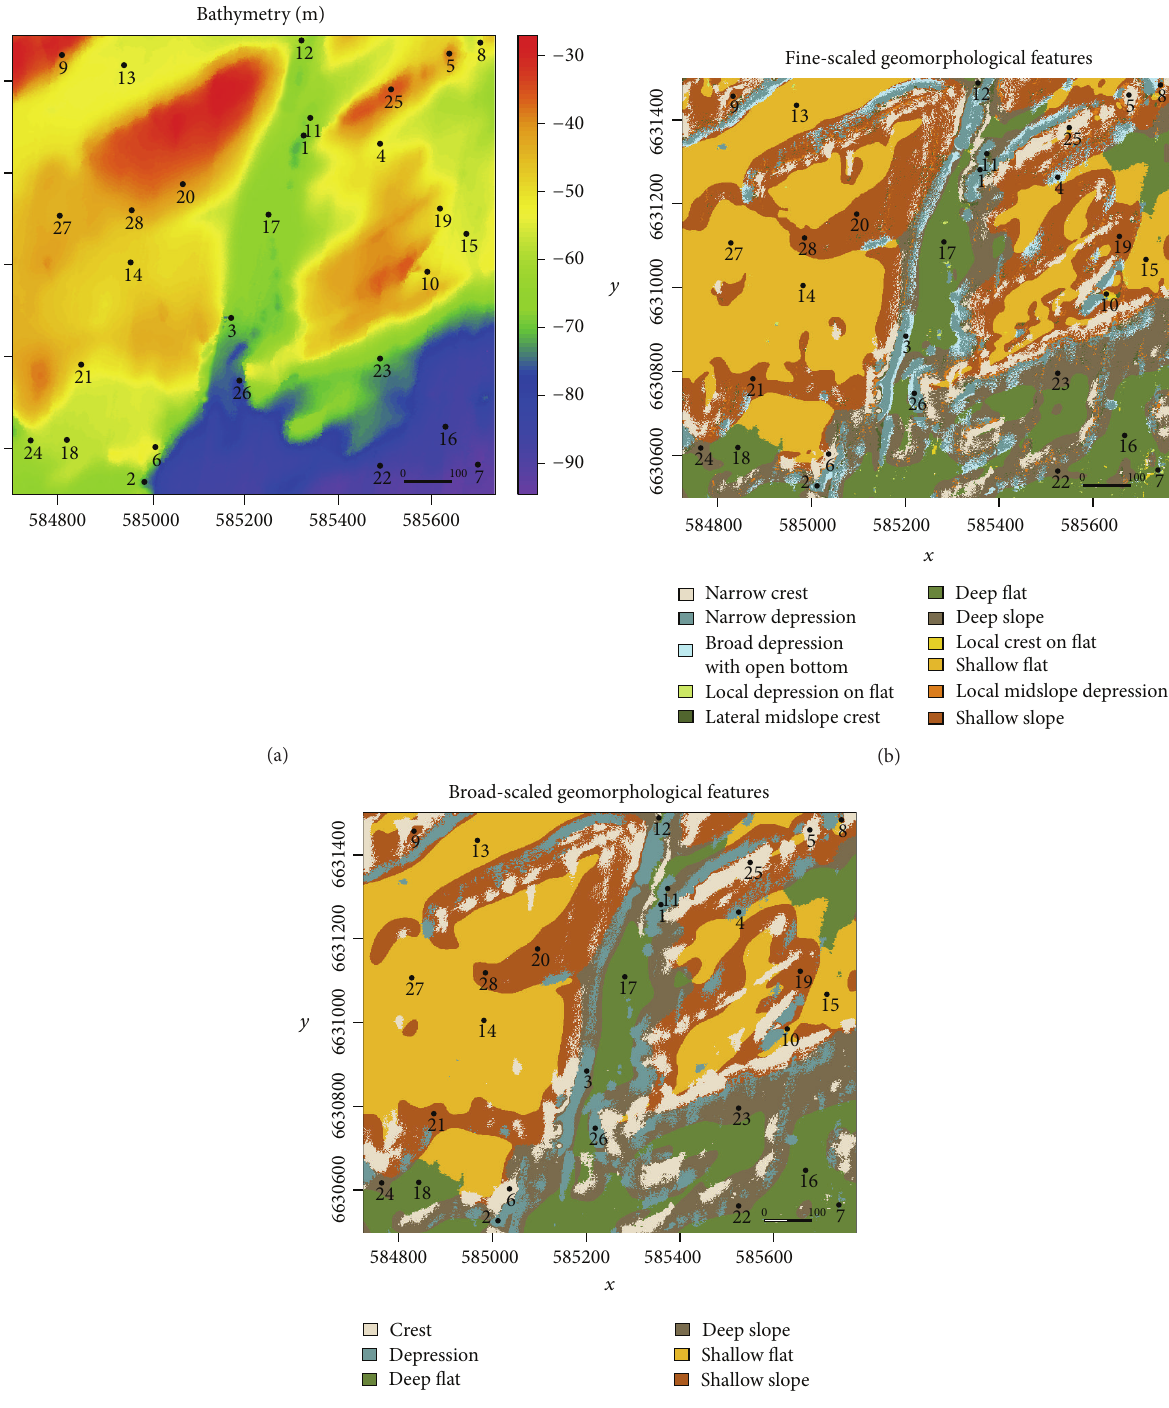
Figure 2: Bathymetry raster (a) showing the depth in meters, map of fine-scaled geomorphological features (b), and broad-scaled geomorphological features (c) in the study area. The maps of the geomorphological features were obtained by applying a modified version of the classification algorithm in Lundblad et al. [23]. The numbers indicate the location of the 28 sampled sites. All maps are scaled in UTM 32N